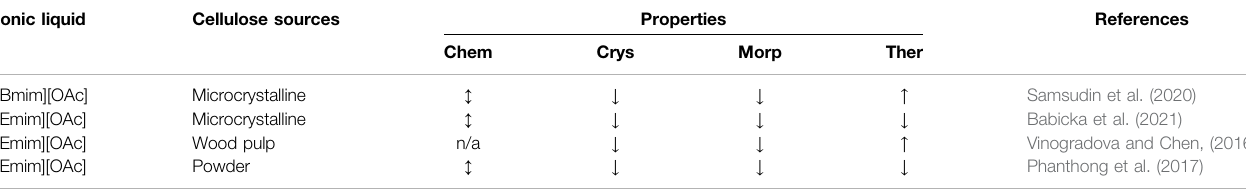
TABLE 6 | Properties of nanocellulose extracted by acetate anion-based ionic liquids. Ionic